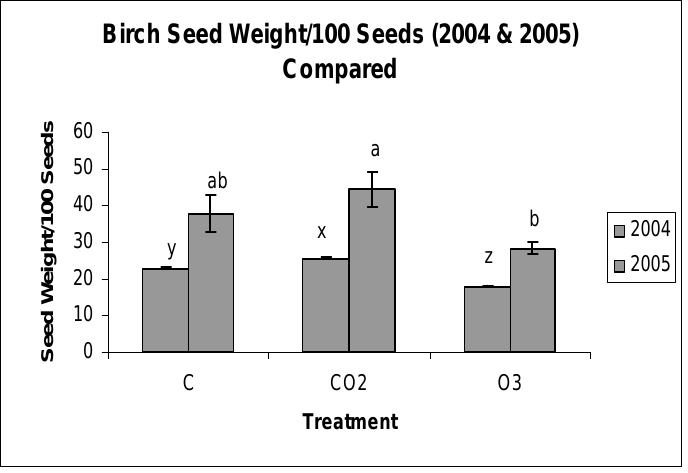
Means are of three replicates. Means within a row not followed by the same letter are significantly different ( p < 0.05).